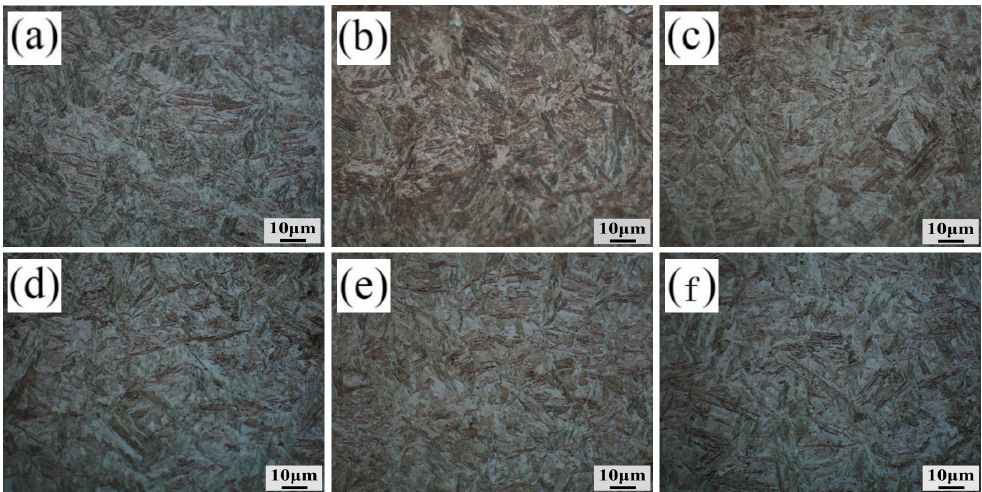
Figure 4. The microstructures of the 22Mn3SiNb steel at the different cooling rates. ( a ) 1 °C/s, ( b ) 5 °C/s, ( c ) 10 °C/s, ( d ) 20 °C/s, ( e ) 30 °C/s, ( f ) 50 °C/s.